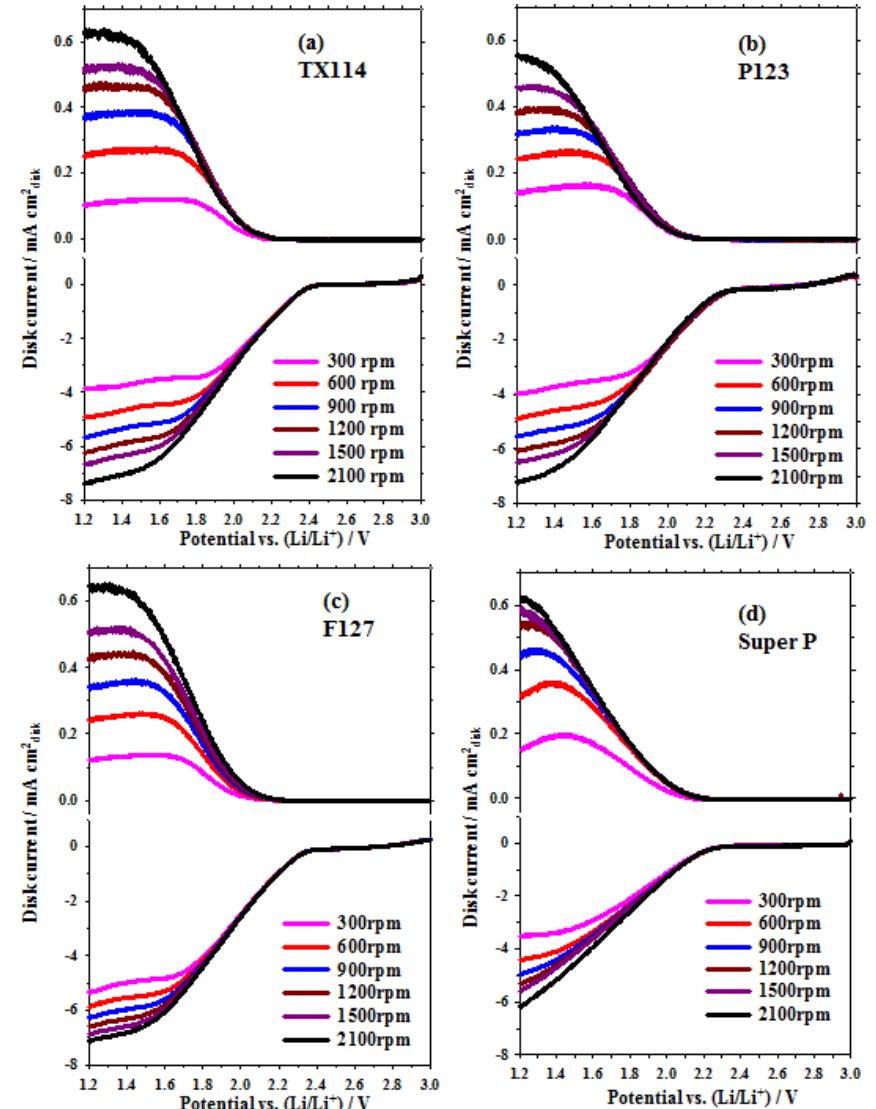
Figure 4. RRDE profiles for Mn 3 O 4 /C composites and Super P (SP), recorded at 50 mV·s −1 in an O 2 -saturated 0.1 M TBAPF 6 /propylene carbonate (PC) solution, at rotation rates between 300 and 2100 rpm (the Pt ring is maintained at 2.6 V Li : ( a ) TX114; ( b ) P123; ( c ) F127; and ( d ) Super P.